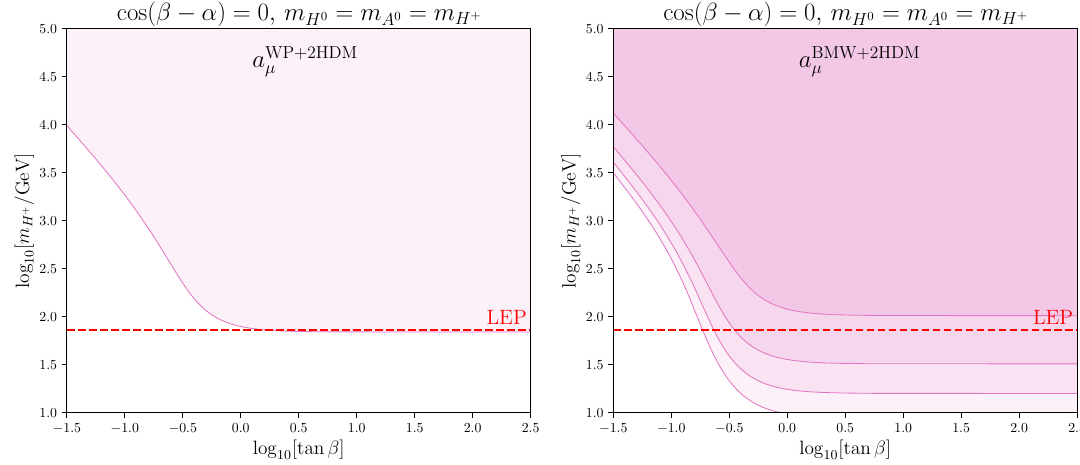
Figure 11 . Contour plot of allowed 2HDM-I parameter space in the ( tan β − m taken in the limits of alignment ( cos( β − α ) = 0 ) and degenerate masses ( m In the left plot, the SM prediction taken from the theory initiative is used; in the right, the SM result from the BMW collaboration. Contours are plotted representing allowed parameter space at 1,2,3,4,5 σ confidence from darkest to lightest: in the left plot, only the 5 σ contour is visible; in the right, the 2 , 3 , 4 , 5 σ contours. The red dashed line indicates the LEP lower bound for m Type I 2HDM ( 72 . 5